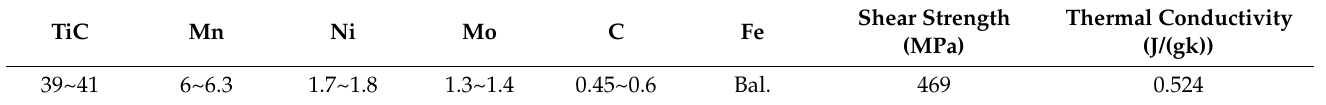
Table 1. Chemical (wt.%) and mechanical properties of investigated samples.